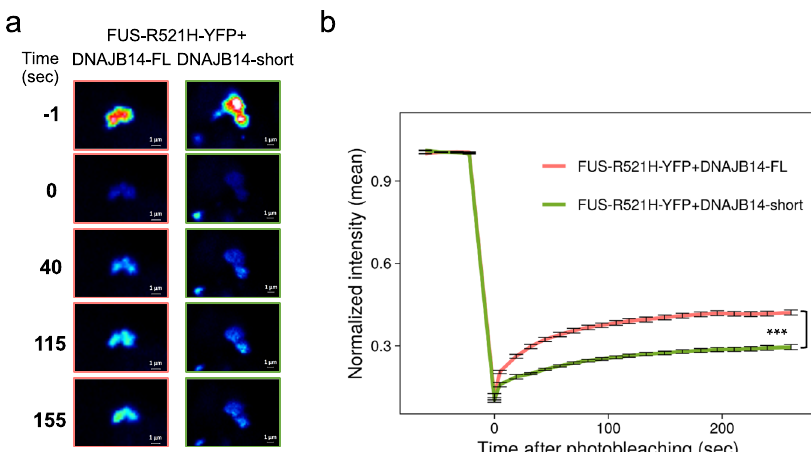
Fig. 5 DNAJB14-FL increased the mobility of mutFUS aggregates. a FRAP analysis ( fl uorescence recovery after photobleaching) was performed on mutFUS aggregates in cells co-expressing FUS-R521H-YFP together with either DNAJB14-FL or -short. A single aggregate is shown over time, Time = 0 denotes photobleaching. b Normalized intensity values for each aggregate ( n = 156 for DNAJB14-FL expression and n = 150 for DNAJB14-short) were binned by time (20 timepoints per bin) and a median value for each bin was calculated. The intensity values right after photobleaching were used as t = 0. For the plot, a median value and a standard error of each bin across all aggregates in cells co-expressing either DNAJB14-FL or DNAJB14-short were calculated. Data are presented as median values ± SEM. T-test (two-sided) was performed for each pair of bins between the DNAJB14-FL and DNAJB14- short values. P -values (FDR-corrected) were signi fi cant (<0.01) in all bins, accept for the t = 0 sec and t = 5 sec, *** p = 1.4e − 14 at the last bin (260 – 280 s after photobleaching).